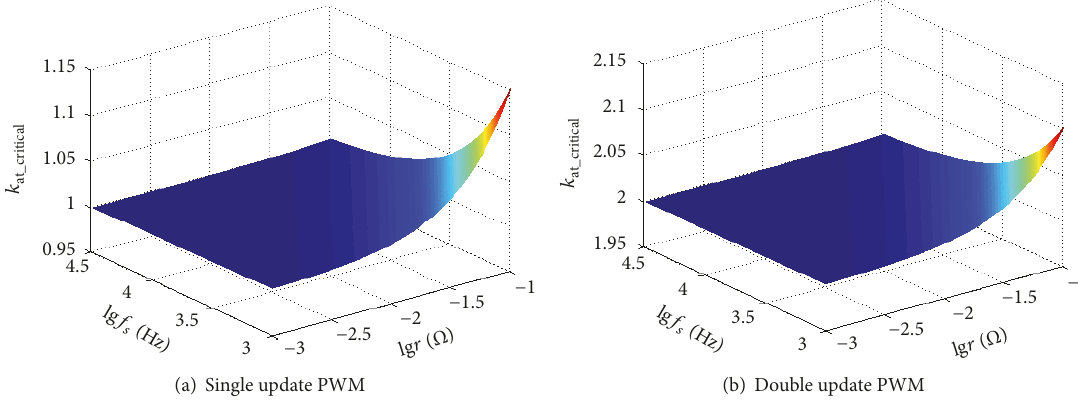
Figure 6: Relationship among the resistance r , sampling frequency f